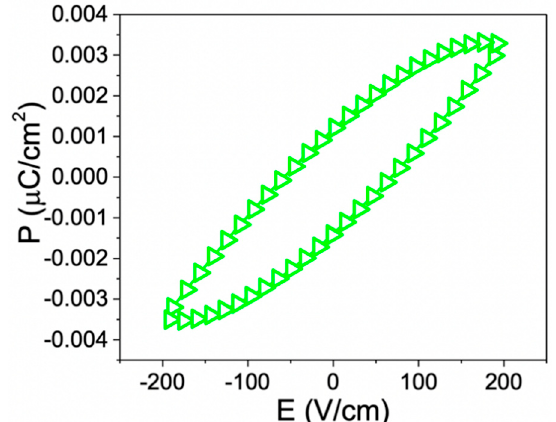
Figure 5. Polarization-electric field hysteresis loops of ZnO nanorod film.